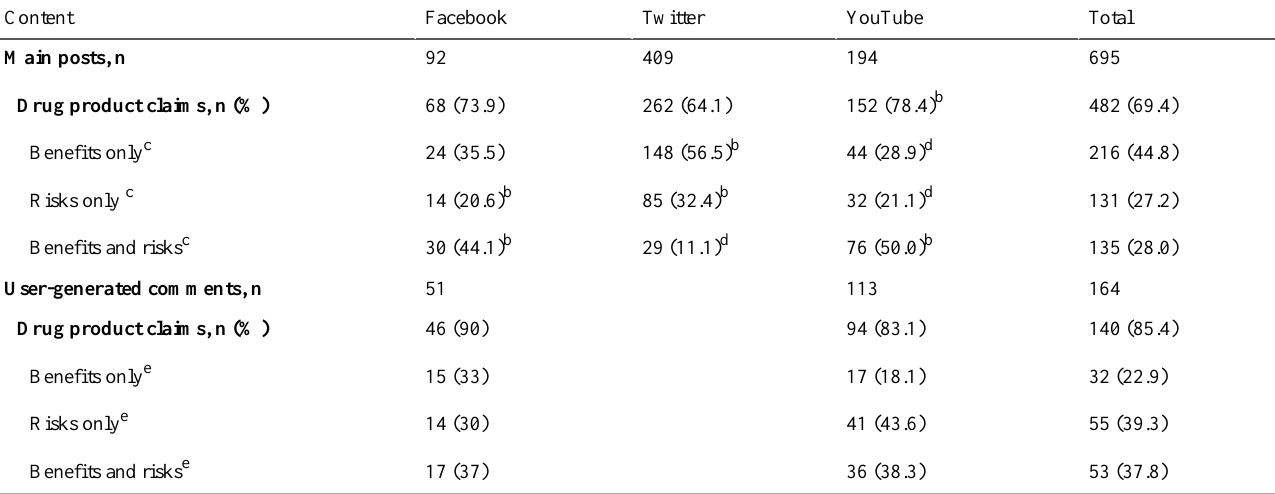
Table 5. Drug product claims in the drug-specific analysis. a